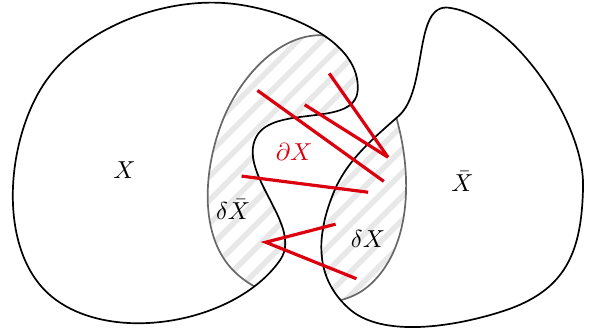
FIG. 2. A graph can be partitioned into two sets of vertices X and ¯ X . The vertex boundary δ X of X is the set of vertices outside of X that are directly connected to X , and similarly for δ ¯ X and ¯ X . The edge boundary ∂ X (red) of X (and ¯ X ) is the set of edges that connect X to ¯ X